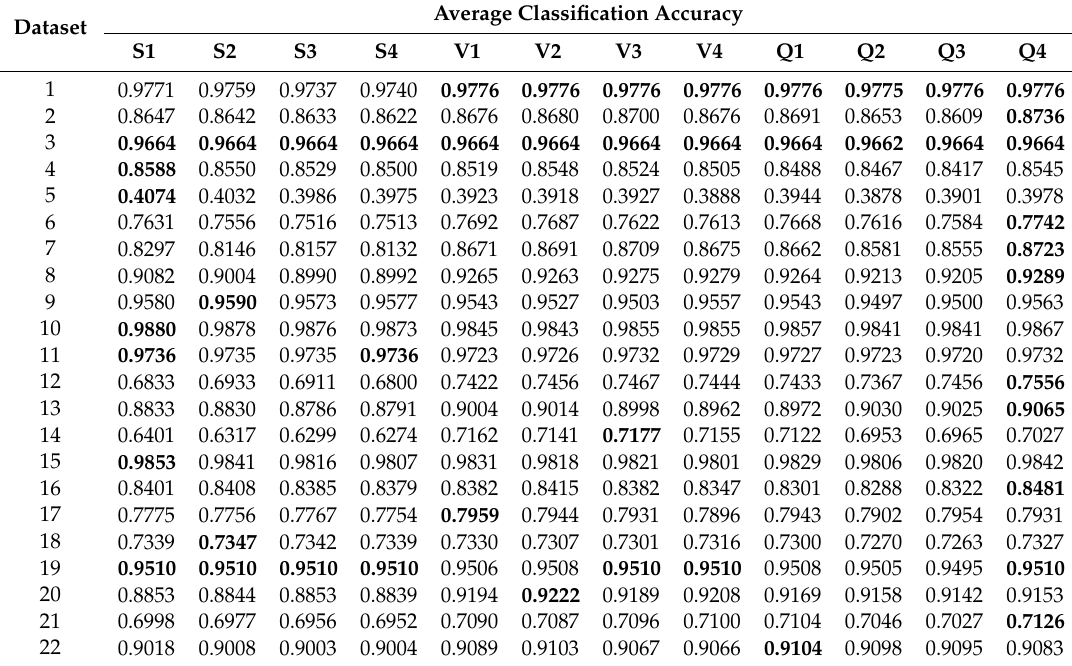
Table 7. Experimental result of the average classification accuracy of the proposed algorithms.